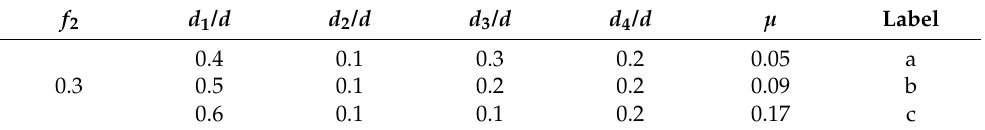
Figure 6. The frequency dependencies of the imaginary part of nonlocal corrections to the effective permittivity at f 1 = 0.7, f 2 = 0.3: ( a ) d 1 / d = 0.4, d 2 / d = 0.1, d 3 / d = 0.3, d 4 / d = 0.2, ( b ) d 1 / d = 0.5, d 2 / d = 0.1, d 3 / d = 0.2, d 4 / d = 0.2, and ( c ) d 1 / d = 0.6, d 2 / d = 0.1, d 3 / d = 0.1, d 4 / d = 0.2. Table 3. The geometrical parameters which correspond to Figure 6.